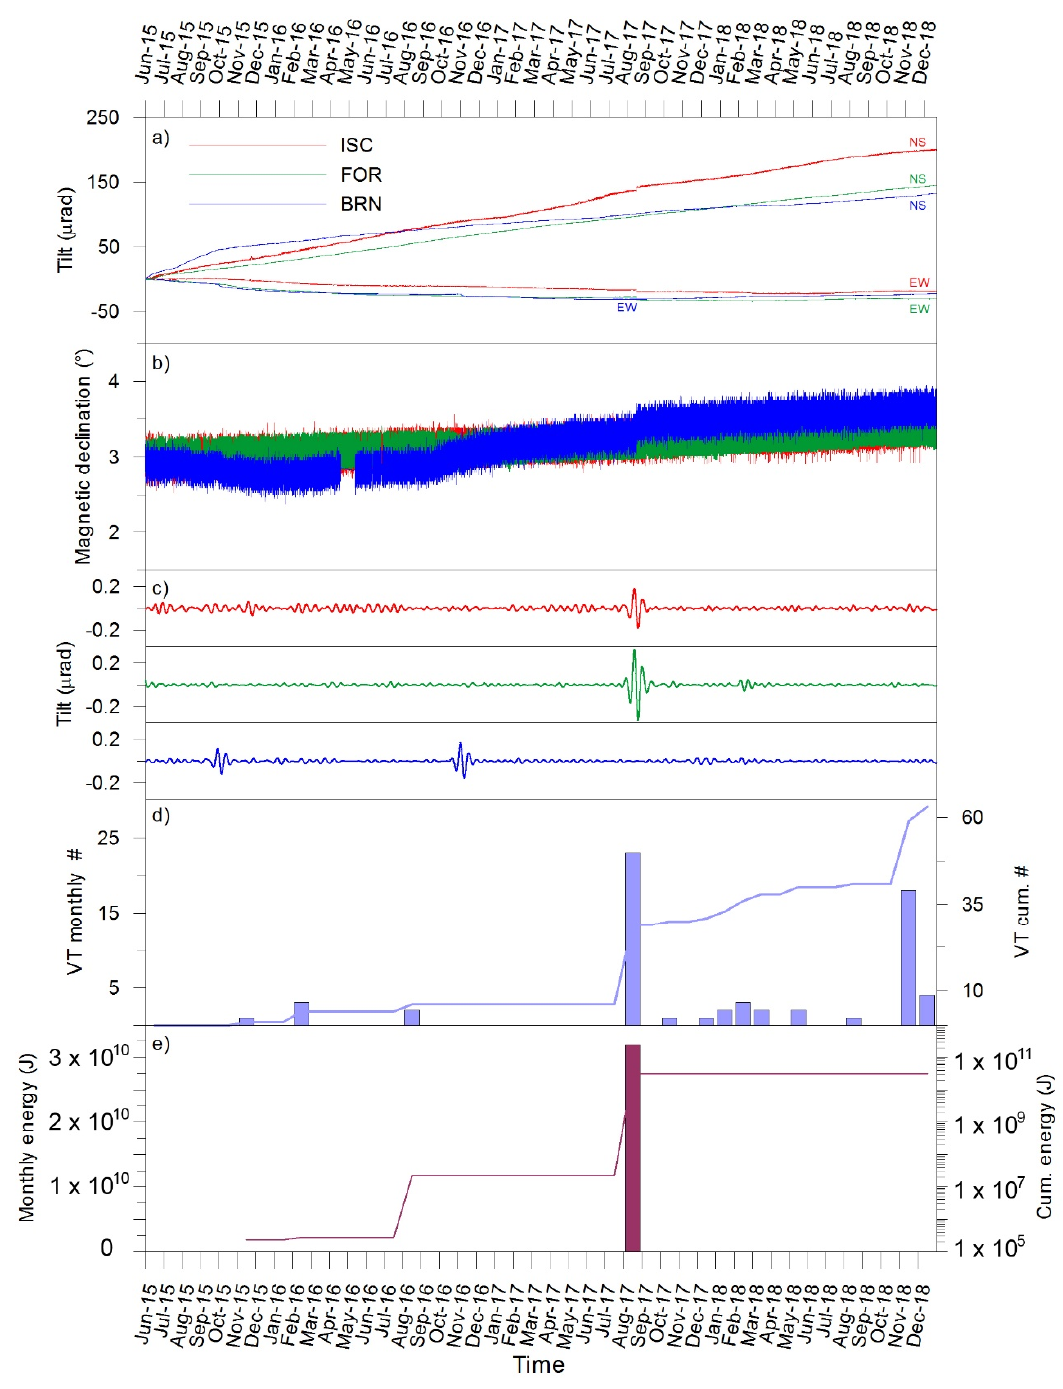
Figure 12. ( a ) Tilt time series from 1 June 2015 to 31 December 2018 for ISC, FOR and BRN (NS and EW components); ( b ) magnetic declination recorded at the three instruments; ( c ) tilt time series ISC, FOR and BRN (EW components) filtered in the period band corresponding to the Mf constituent; ( d ) monthly (bar plot) and cumulative (continuous line) number of VTs; ( e ) monthly (bar plot) and cumulative (continuous line) energy release of VTs.